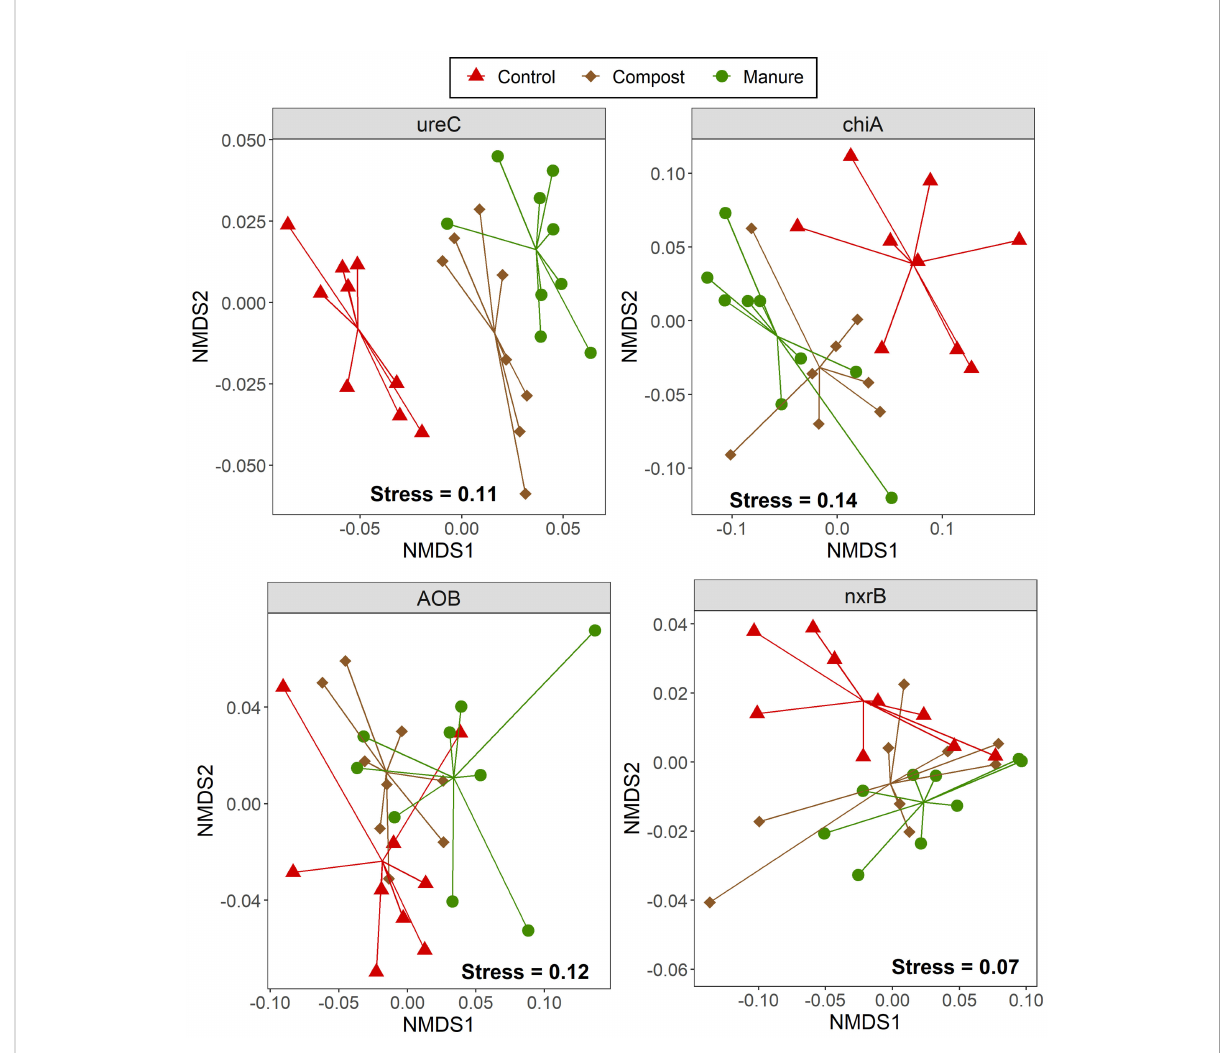
FIGURE 4 NMDS ordination of the weighted UniFrac distance for four N-cycling functional groups. Four N-cycling genes were ureC (encoding urease), chiA (encoding chitinase), bacterial amoA (encoding ammonia monooxygenase) and Nitrospira nxrB (encoding nitrite oxidoreductase). Except for Nitrospira nxrB , organic N treatment signi fi cantly changed the community composition of other N-cycling functional groups (p <